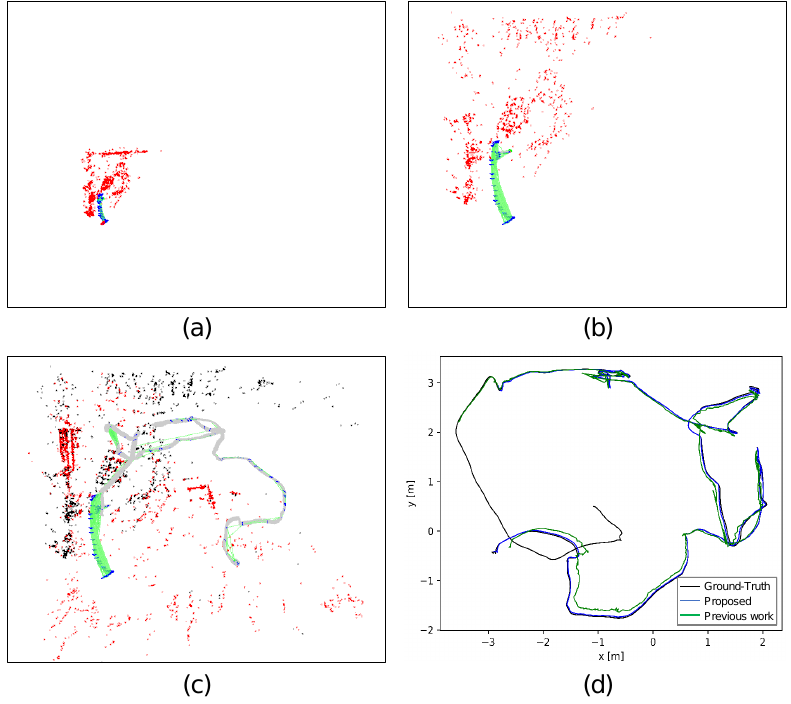
Figure 2. An example of the estimated maps before and after applying the proposed method. The data are from the V2_01 sequence of the EuRoC dataset [37] with a time offset of 45 ms. ( a ) The map estimated by monocular VO. It is subjected to ambiguous scales. ( b ) The map after initialization. The metric-scale was recovered. ( c ) The map constructed by the proposed method on the whole sequence. ( d ) A top-view of the estimated trajectory (blue curve) compared with the ground-truth (black curve) and our previous work [36] (green curve, which calibrates the extrinsic spatial parameter only). Best viewed in